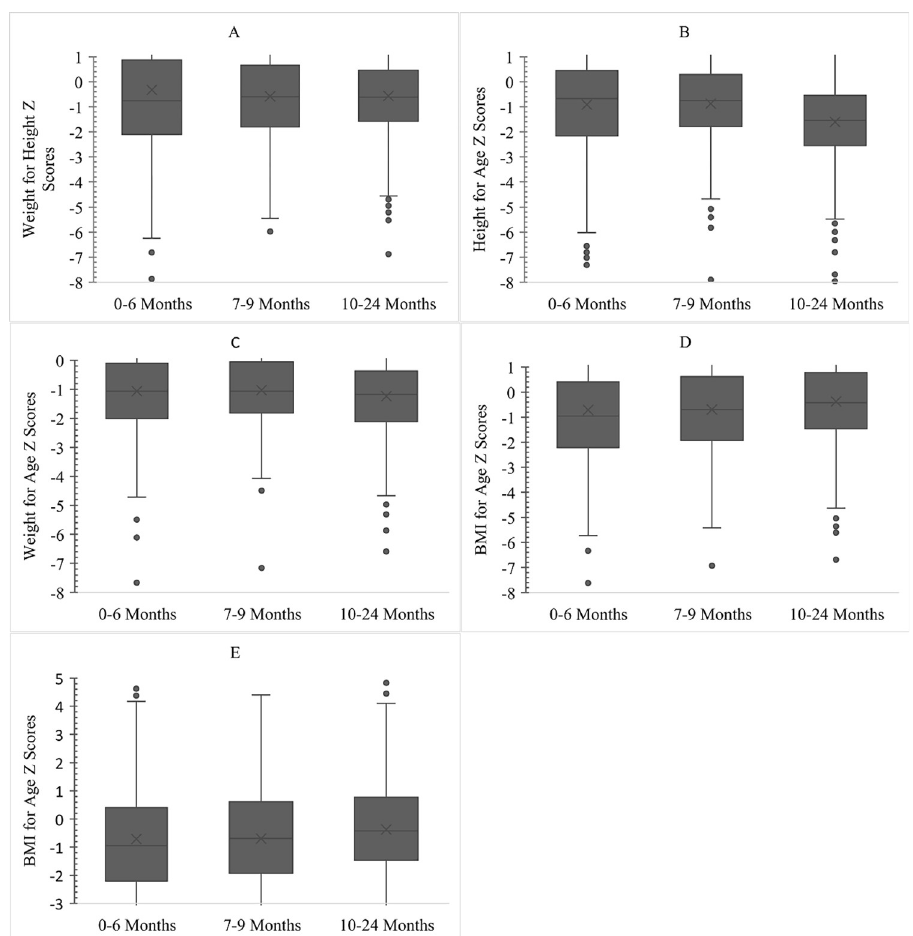
Fig 1. Age wise distribution of nutritional indicators. A. Weight for Height (Wasting) B. Height for Age (Stunting) C. Weight for Age (Underweight) D. BMI for Age (BMI Wasting) E. BMI for Age (Overweight and Obesity).